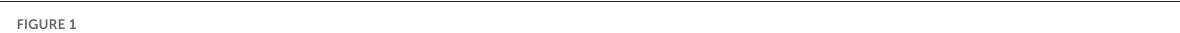
FIGURE1 following the last addition of inhibitors. (B) Virus titer upon the addition of combinations of the DAAs daclatasvir and sofosbuvir. The virus used for infection is indicated in the upper filled boxes, and the inhibitor concentrations in the cell culture medium are given in the empty box. The abscissa shows the time post-infection of addition of the drug combination. (C) Same as (B) except that the inhibitors used were combinations of the mutagenic nucleoside analogs favipiravir and ribavirin. For (B,C) , the statistical significance of the differences between values given in the bars are given as follows: * p < 0.05; ** p < 0.01; *** p < 0.001; t-test). Viral titer values can be found in Supplementary Table S2. Extracellular RNA values can be found in Supplementary Table S3 and Supplementary Figure S2. Experiments were performed in triplicate (replicas A, B, and C